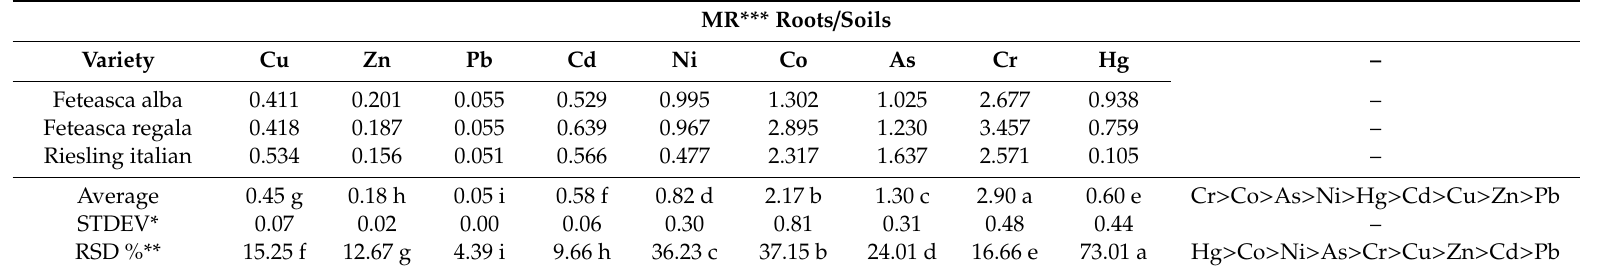
Table 6. The mean values of mobility ratio in system soil-grape-wine. MR*** Roots /